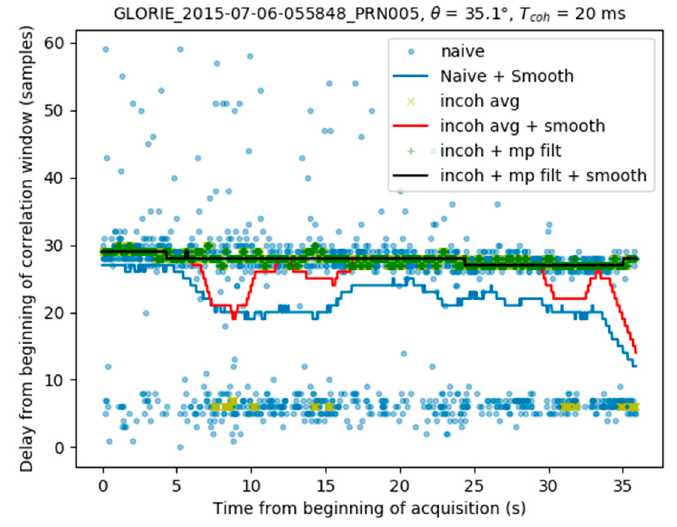
Figure 12. Smoothing of the direct signal mitigation algorithm result.